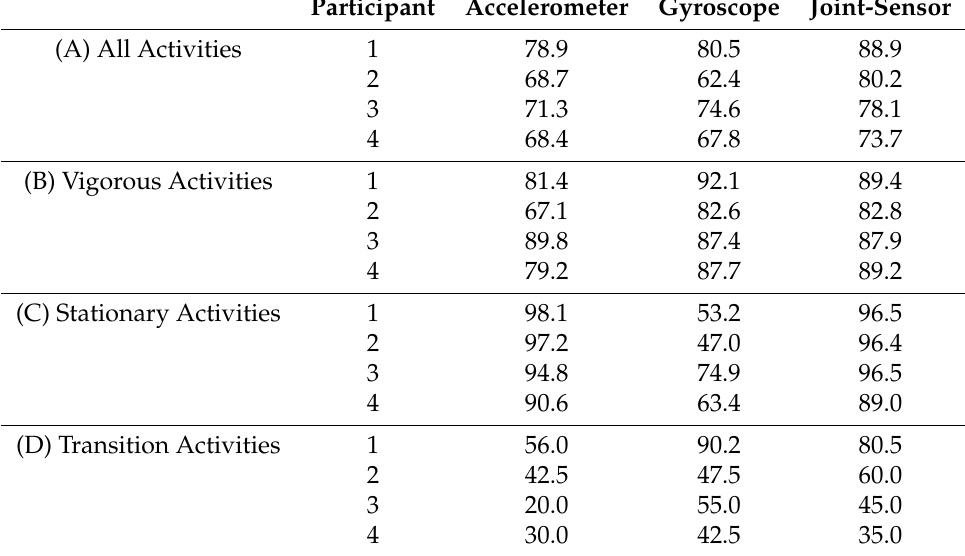
Table 3. Average accuracy of each method for different activity groups. The vigorous activities included walking, ascending stairs, and descending stairs. The stationary activities included sitting and standing. The transition activities included stand-to-sit and